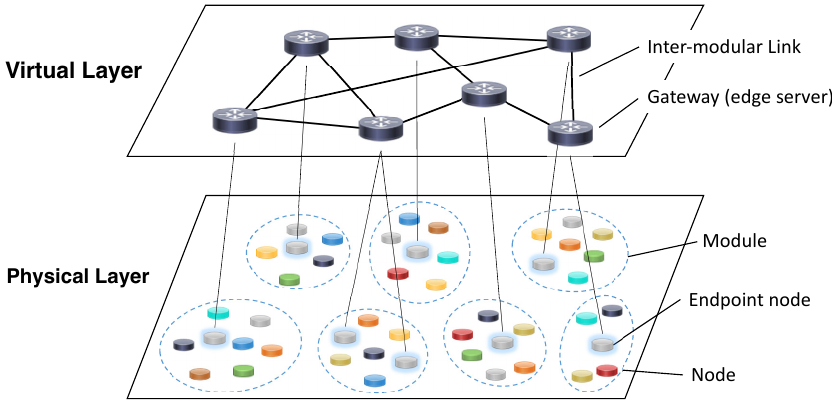
Figure 2. Architecture for virtualized wireless sensor